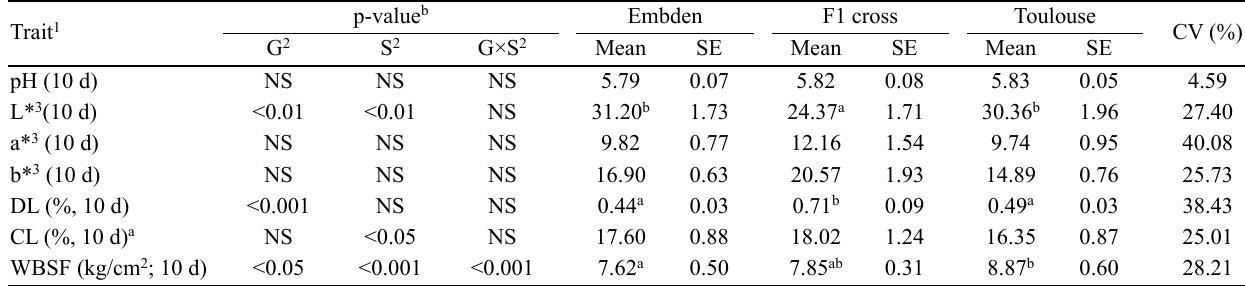
WBSF (kg/cm 2 ; 10 d) ANOVA, analysis of variance; SE, standard error; CV, coefficient of variation; NS, not significant; DL, drip loss; CL, cooking loss; WBSF, Warner– Bratzler shear force. 1 Sample weight as covariate in the covariance analysis.